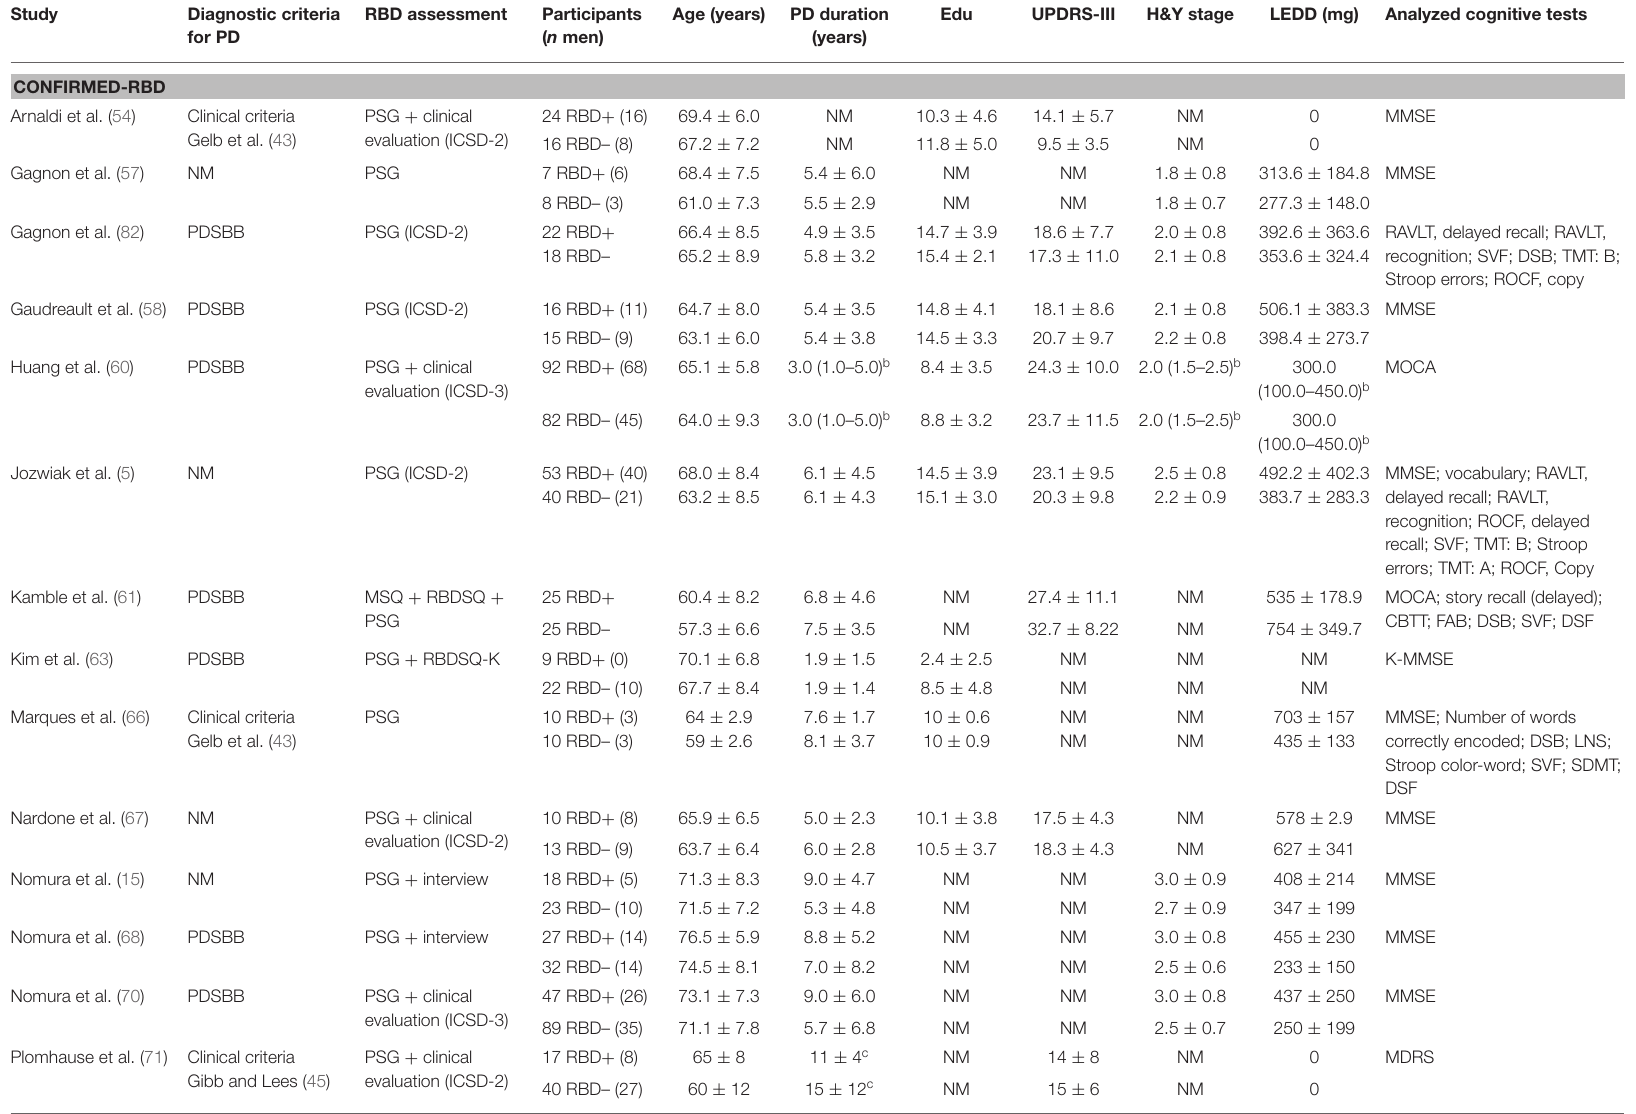
TABLE 2 | Characteristics of the primary studies included in the